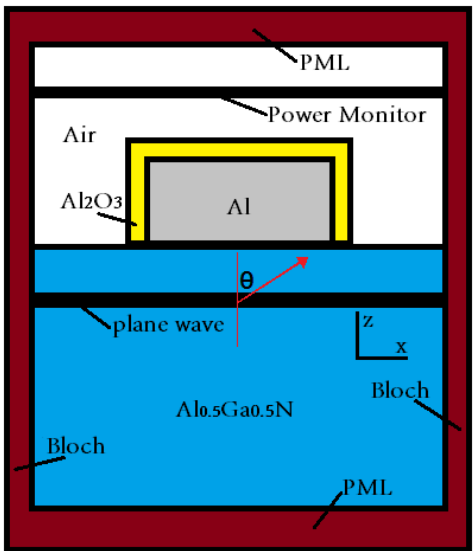
Figure 1. Schematic diagram of the 3D FDTD computational model for the SP-coupled LED.